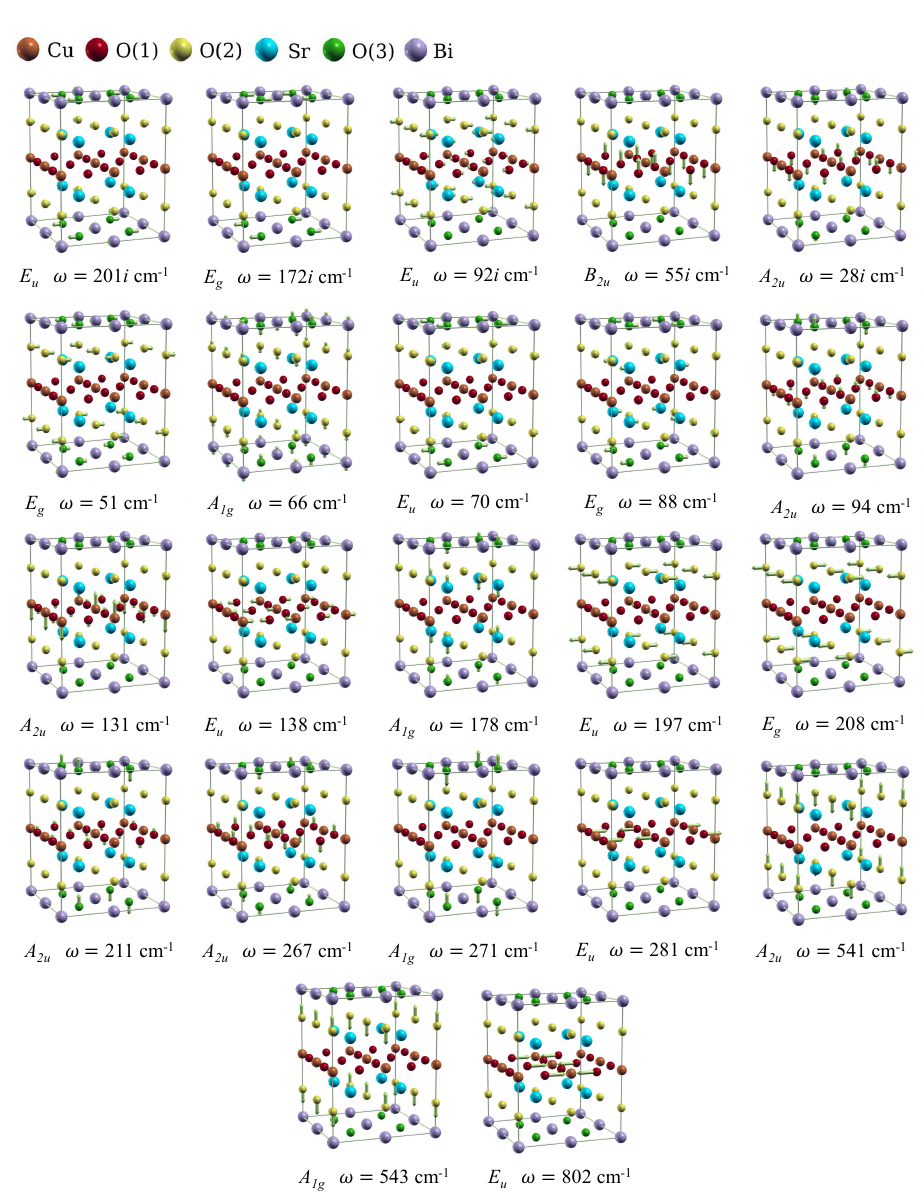
Figure A5: All Bi2201 modes at the X